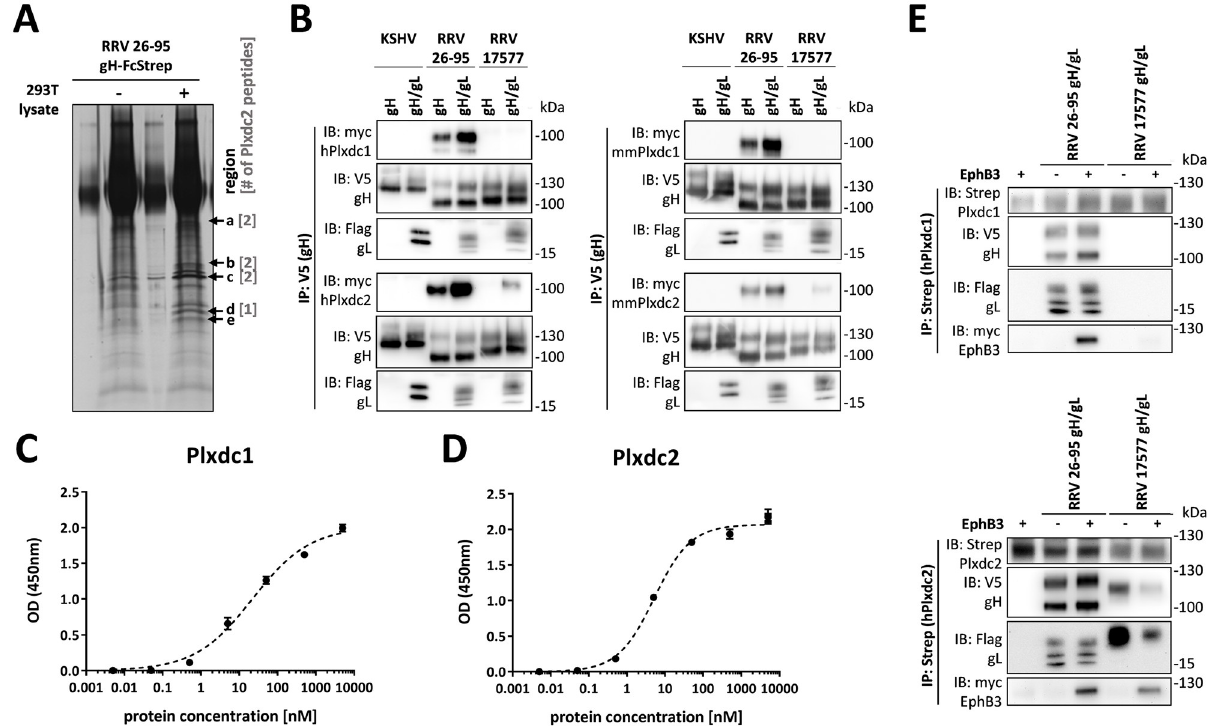
Fig 1. Plxdc family receptors are novel interaction partners for RRV gH/gL. A) Immunoprecipitation of recombinant soluble RRV 26–95 gH-FcStrep in the presence or absence of 293T lysate. Precipitates were analyzed by PAGE, silver stained and bands at the indicated molecular weight (arrows, regions a-e) were excised and analyzed by mass spectrometry. Numbers in brackets indicate the number of Plxdc2 peptides identified by LC-MS/MS in each region. B) V5-tagged RRV 26–95 gH, RRV 17577 gH or KSHV gH alone or co-expressed with the respective Flag-tagged gL construct were immunoprecipitated in the presence of full-length Plxdc1 or Plxdc2 of human (h) or Macaca mulatta (mm) origin using monoclonal antibody to the V5-tag. Precipitates were analyzed by Western blot with the indicated antibodies. C-D) Binding of Plxdc1 ectodomain C) or Plxdc2 ectodomain D) at various concentrations to immobilized RRV 26–95 gH-FcStrep/gL was measured by enzyme-linked immunosorbent assay. Curve Fitting and determination of half-maximal binding concentration was performed based on the One site specific binding with Hill Slope equation in Prism6. E) Co-immunoprecipitation of soluble human Plxdc1-FcStrep or human Plxdc2-FcStrep with RRV 26–95 gH-V5/gL-Flag or RRV 17577 gH-V5/gL-Flag using StrepTactin sepharose in the presence or absence of human full-length myc-tagged EphB3. Abbreviations: IP: immunoprecipitation, IB: immunoblotting, h: human, mm: Macaca mulatta (rhesus macaque).